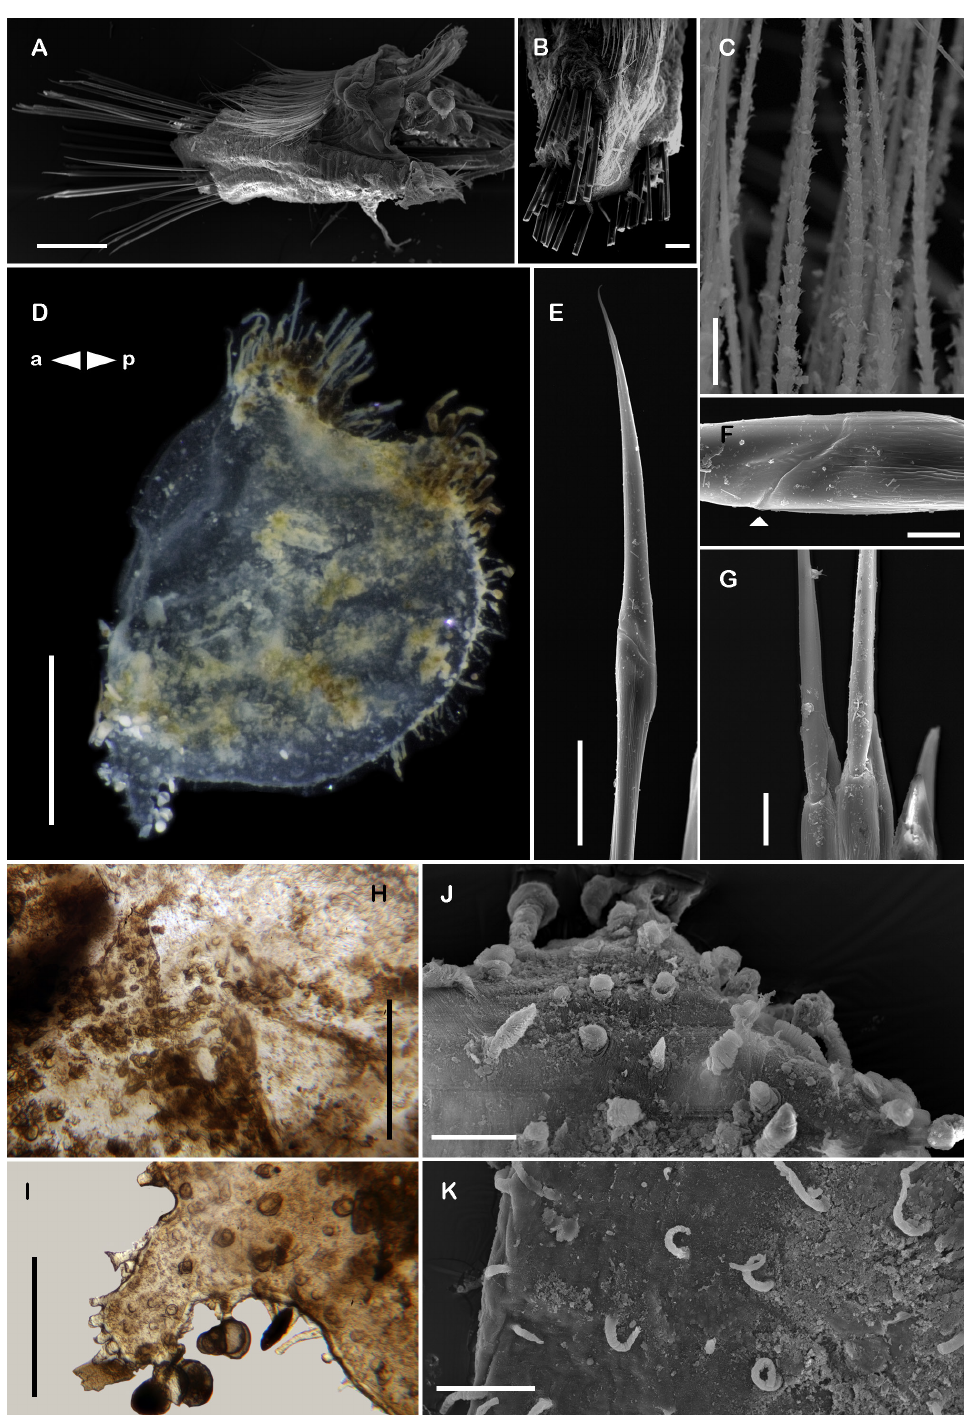
Fig. 24. Psammolyce flava Kinbergi, 1856, non-type material (UMML 6720-927). A–C, E–G, J–K. SEM micrographs. A . Right parapodium from segment 30. B . Parapodium from segment 31, neurochaetae removed, dorsal view. C . Notochaetae from A. D . Posterior elytron. E . Unit D from A. F . Insertion of blade on the handle, arrow indicates ligament. G . Ventral view of unit A from A. H . Surface of posterior elytron. I . Medial process of posterior elytron. J . Surface of posterior elytron, globular papillae. K . Surface of posterior elytron, dendritic papillae. Abbreviations: a = anterior; p = posterior. Scale bars: A = 500 μm; B = 100 μm; C, G = 20 μm; D = 1 mm; E, J–K = 50 μm; F = 10 μm; H–I = 300